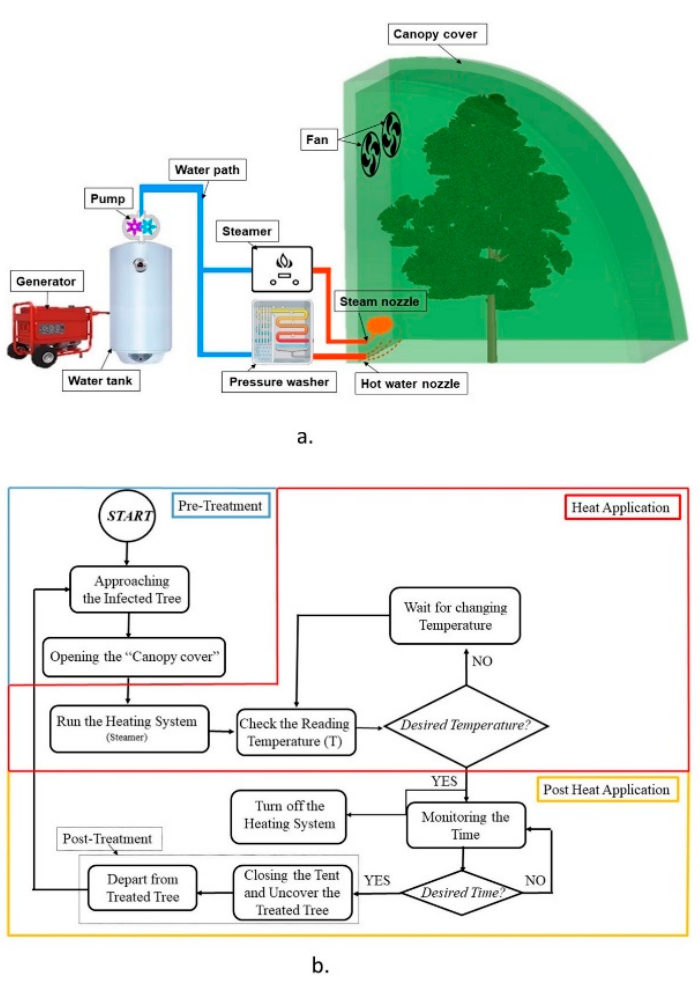
Figure 1. a . Schematic diagram of the mobile heat treatment system (MHTS) system and its components. b . Flowchart of the heat treatment process and its three main parts.